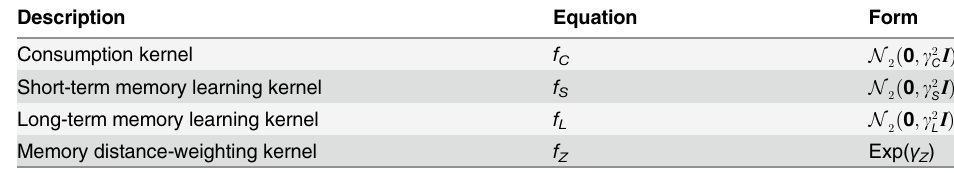
Table 2. Spatial kernels used in the foraging model. N 2 is the bivariate normal distribution and I is the 2 × 2 identity